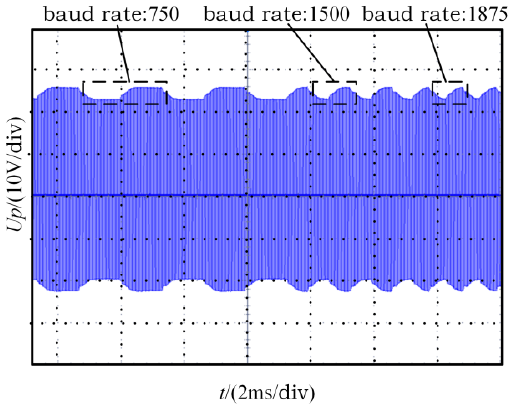
Figure 8. System transmission rate diagram.